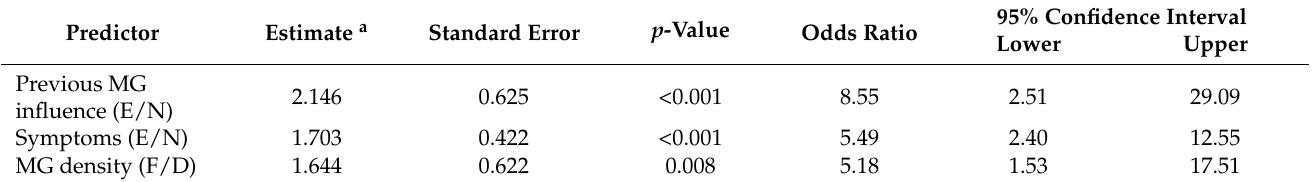
Table 4. Binomial logistic regression analysis for predicting concordance of lesion location between radiologists’ analysis and pathology results.